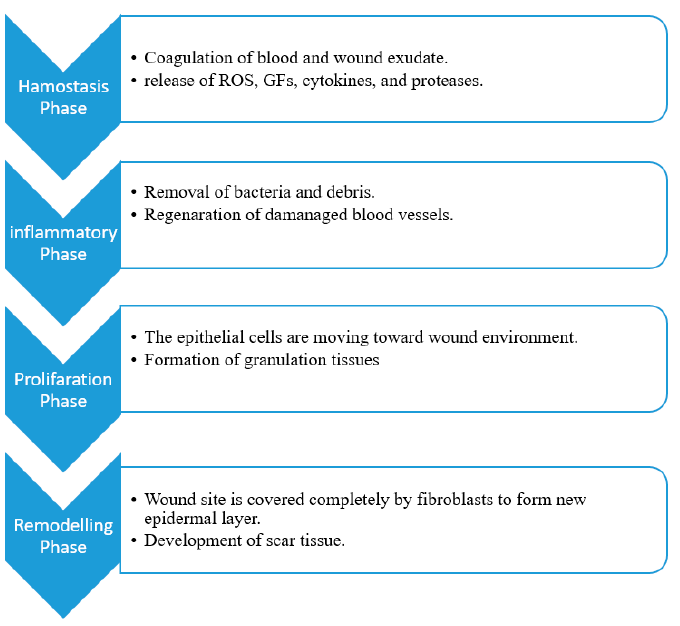
Figure 2. Summarized sequential phases of the wound healing process.